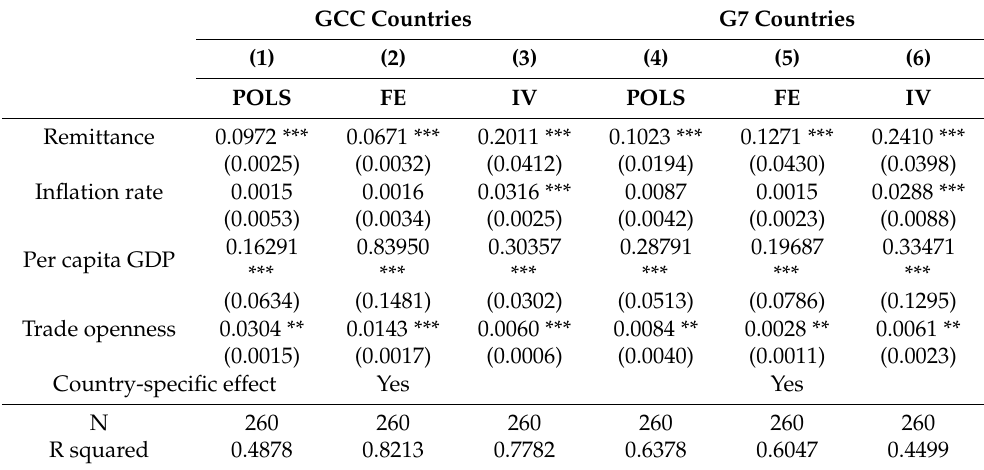
Table 4. Impact of remittance on credit ratio.